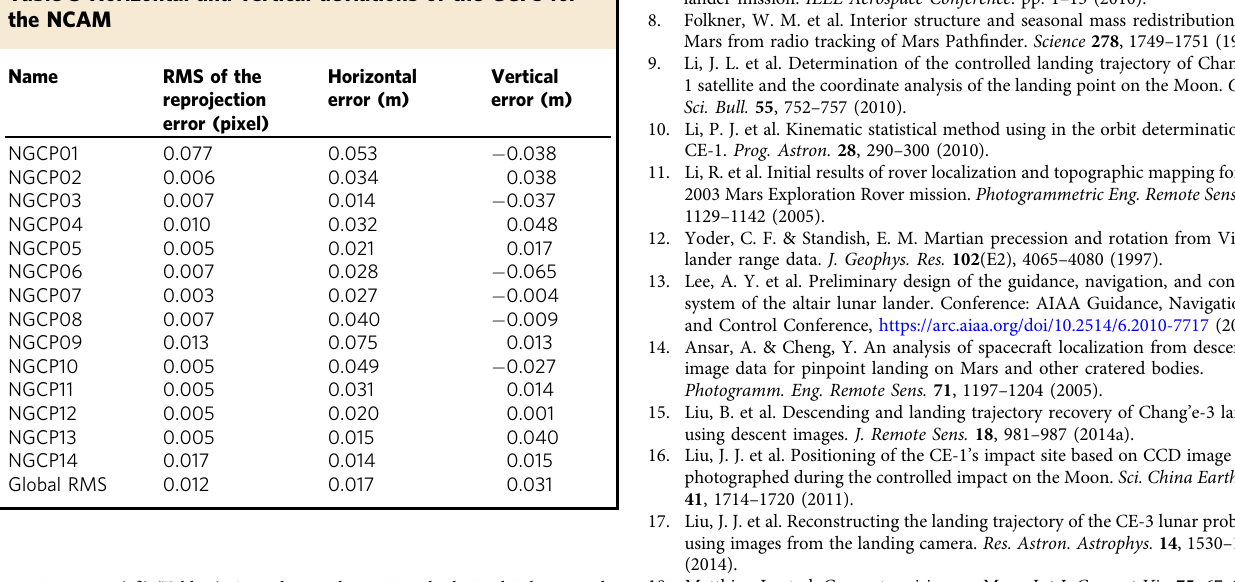
error is 0.031m (1 δ ) (Table 5). According to the positional relationship between the NCAM and the origin of the lander ’ s body coordinate system (LBCS), the horizontal position of the vertical projection of the LBCS origin in the LCAM terrain data is 177.5991°E, 45.4446°S, and the elevation value is − 5935m. Data availability CE2TMap2015 and CE-4 images are available at the Data Publishing and Information Service System of China ’ s Lunar Exploration Program (http://moon.bao.ac.cn/). Datasets generated and/or analyzed during the current study are available from the corresponding author.